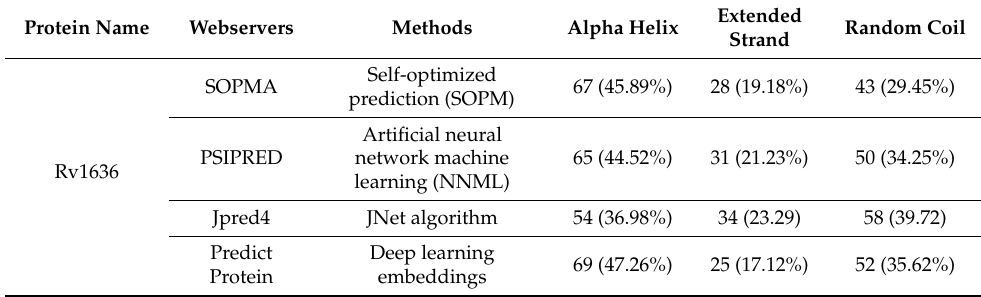
Table 3. Secondary structure profile of Rv1636 protein by the different